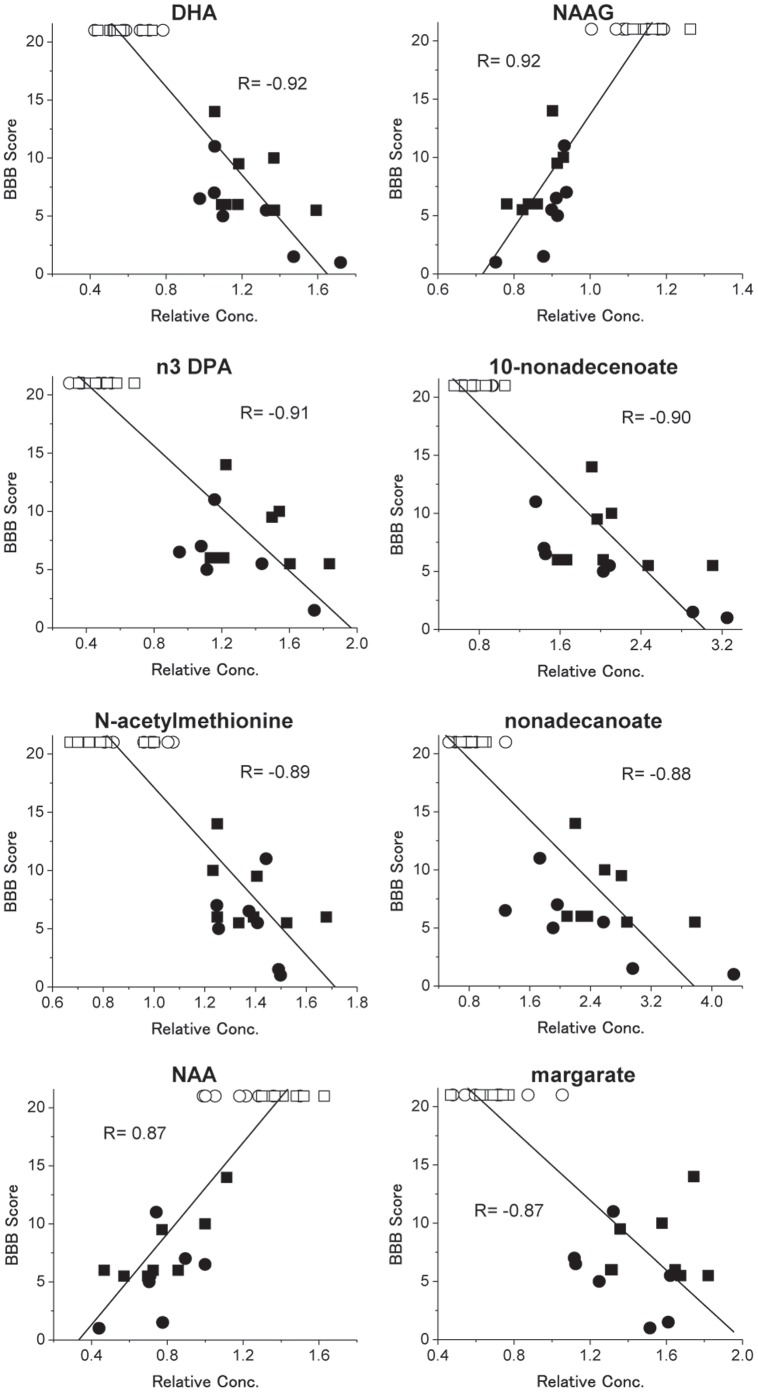
Correlation plots comparing BBB scores with metabolite levels at days 11 (circle) and 30 (square).The eight named metabolites with the highest |R| score are displayed (see Table S2 for complete list). Sham animals (day 11 and 30) received full BBB score ( = 21), consistent with normal movement. SCI at day 11 and 30 are depicted as •(n = 7) and ▪(n = 8). Sham at day 11 and 30 are displayed as ○(n = 8) and □(n = 8). All data points of Sham animals and SCI animals were used to calculate the R values.